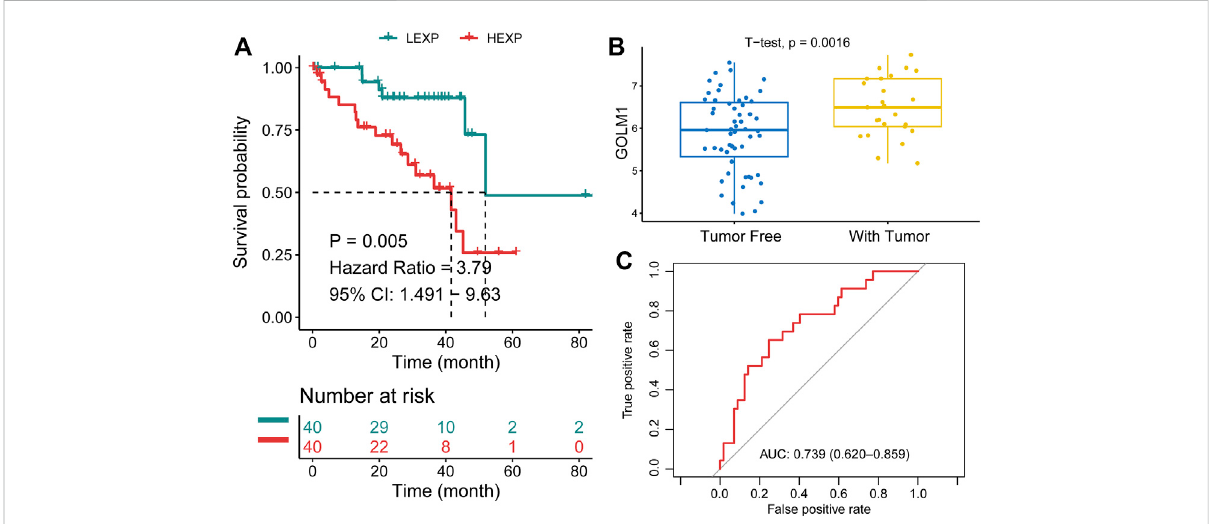
FIGURE 2 Prognostic value of GOLM1 in uveal melanoma. (A) Kaplan – Meier curve showing the polarized overall survival in GOLM1-low (LEXP) and GOLM1-high (HEXP) subgroups; (B) Differential expression of GOLM1 in patients lived with or without tumors; (C) Receiver operating characteristic curve showing the prognostic value of GOLM1.